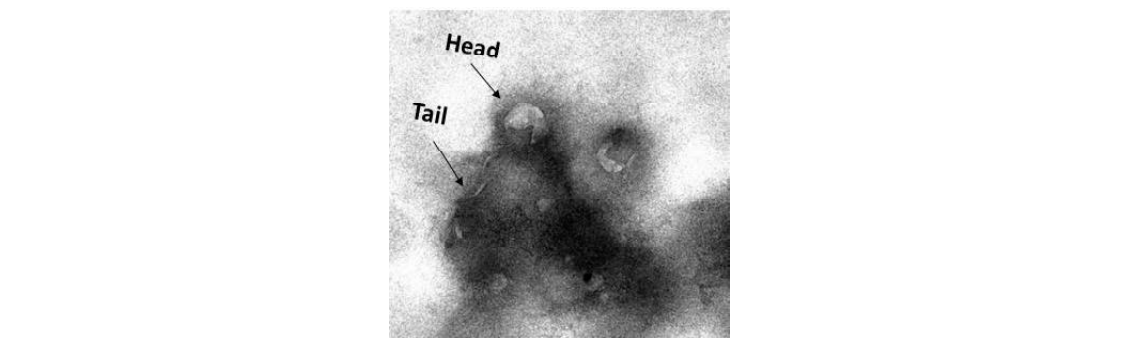
Figure 9: Transmission electron microscopy analysis of the purified PaMAsh phage belongs to